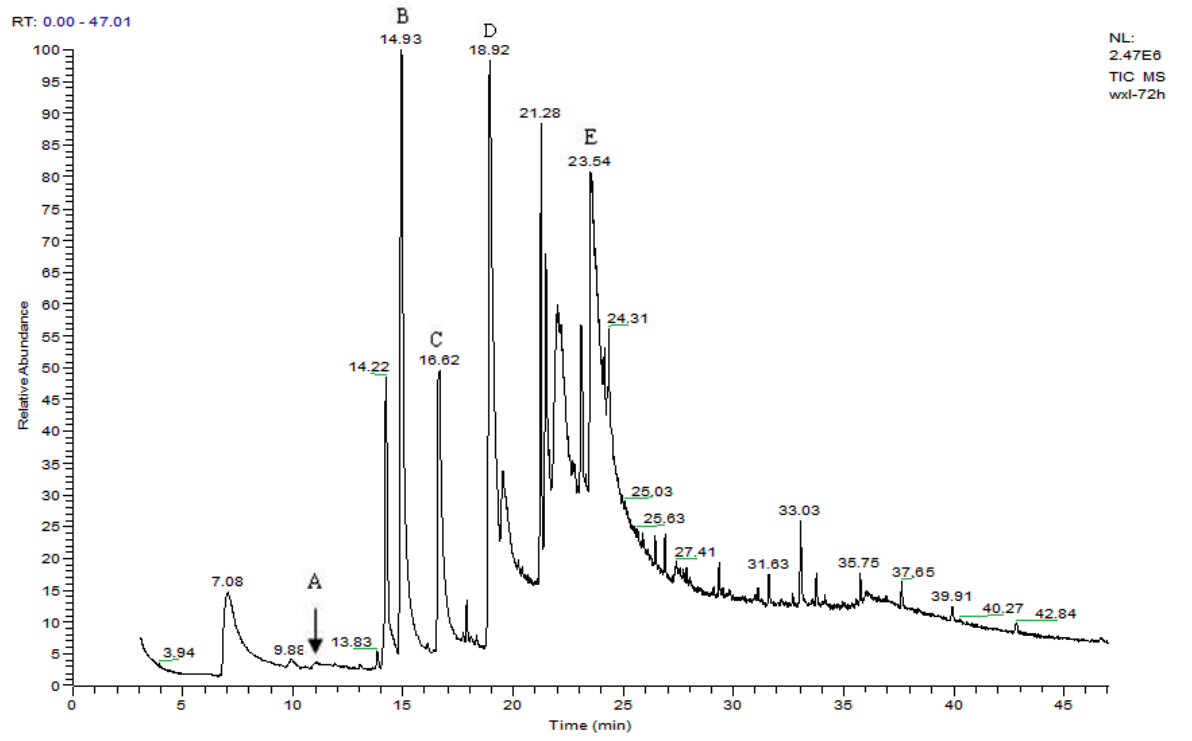
Figure 3. GC spectrum of a 72 h metabolite sample (A. dichlorinated solicylic acid; B. 1,4-dichloronaphthalene; C. dichlorinated salicylic acid; D. epoxy chlorinated naphthalene; E. dichlorinated